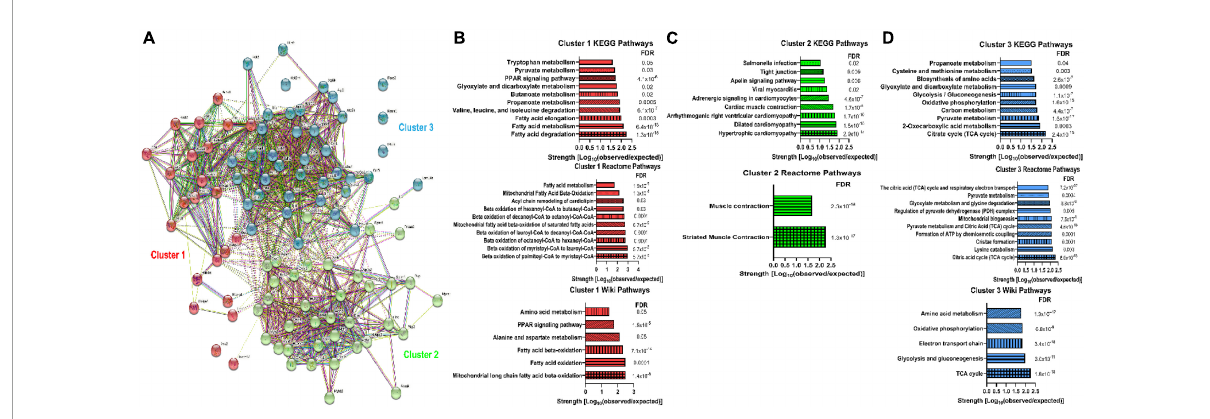
FIGURE1 Bioinformatics analysis of previously identified glycated proteins from murine myocardium suggested a link between protein glycation and mitochondrial metabolic activity. (A) STRING analysis of the previously identified glycated proteins from murine myocardium (17). K-means clustering delineated three clusters of proteins. (B) KEGG pathways, Reactome pathways, and WikiPathways identified in Cluster 1. (C) KEGG pathways and Reactome pathways identified in Cluster 2. No WikiPathways were identified from Cluster 2 proteins. (D) KEGG pathways, Reactome pathways, and WikiPathways identified in Cluster 3. FDR: False discovery